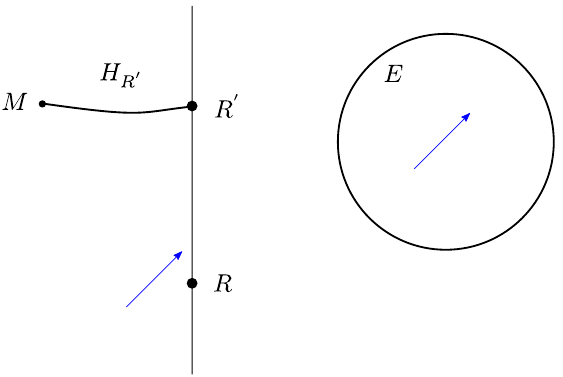
Figure 4 . Two timelike-separated regions of the boundary are depicted, R and R 0 , with R 0 (cid:26) D + [ R ]. The boundary conditions allow modes to pass from the bulk, through the boundary, into the system E . The bulk surface M is anchored to @R = @R 0 and timelike related to R but spacelike related to R 0 . While (cid:27) does not lie on any Cauchy slice anchored to R , we can nevertheless de(cid:12)ne an entropy of (cid:27) with respect to R as the entropy of H R 0 [ E